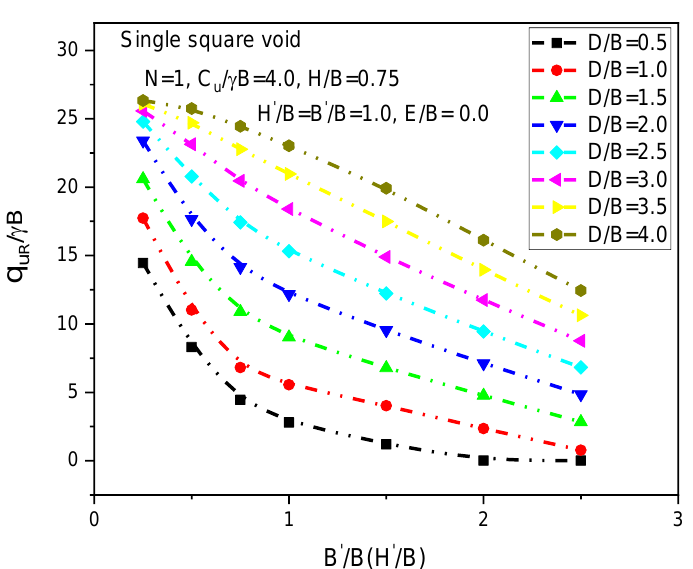
Figure 16. Effect of reinforcement on the ultimate bearing capacity ratio with a change in square void size.